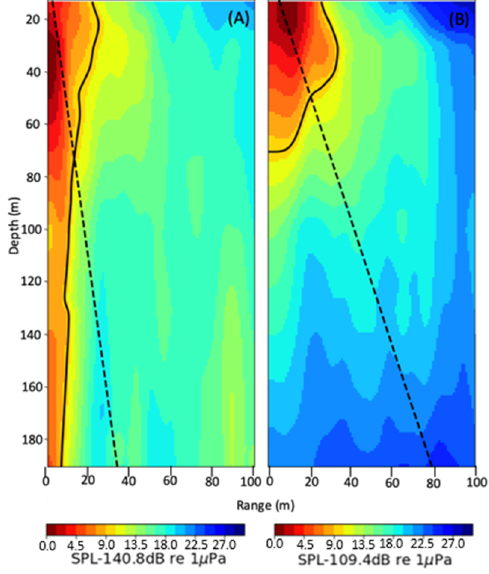
Figure 11. Received sound pressure levels (SPLs) in the SRKW echolocation range (15–100 kHz) over depth and horizontal space from the ( A ) 200 and ( B ) 83 kHz echosounder signals in deep water. The dashed black lines indicate the 20 ◦ and 45 ◦ beam widths for the 83 and 200 kHz channels, respectively. The solid black lines indicate the contour of − 10 dB re 1 m from below the maximum SPL of the frequency range (maxSPL) (measured to be 109.4 dB re 1 µ Pa